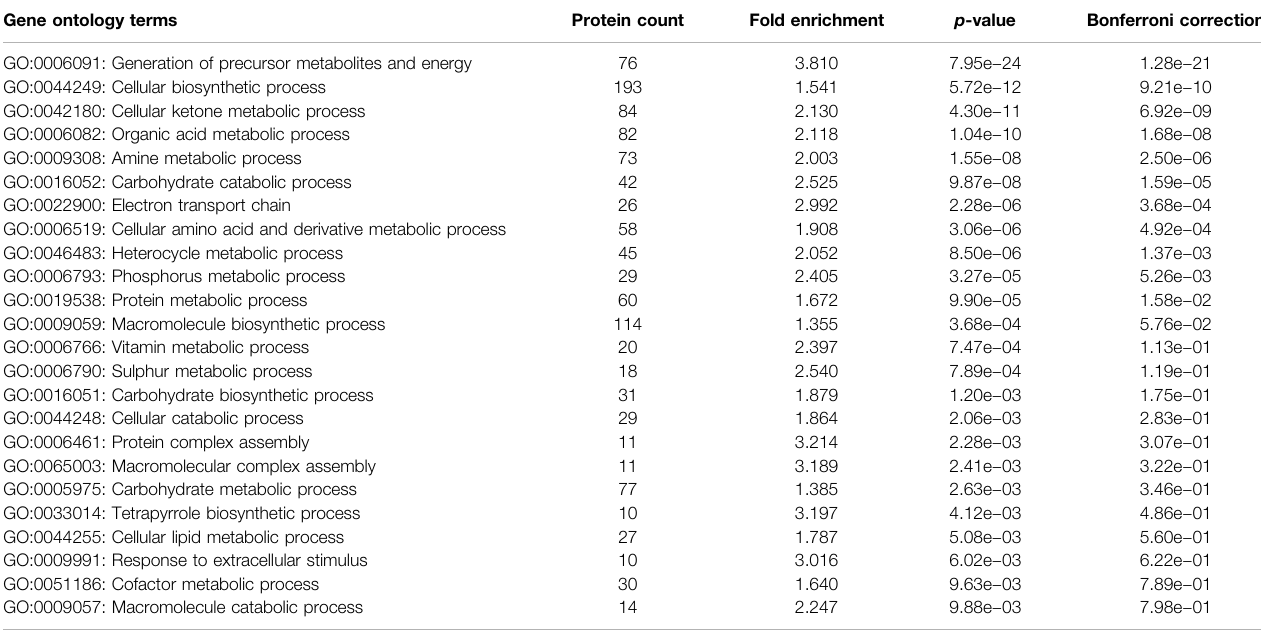
TABLE 2 | Enriched Gene Ontology terms (level 3 - biological process terms), associated with the 404 proteins that were co-enriched/expressed with GroE across different experiments. Gene ontology terms Protein count Fold enrichment p -value Bonferroni